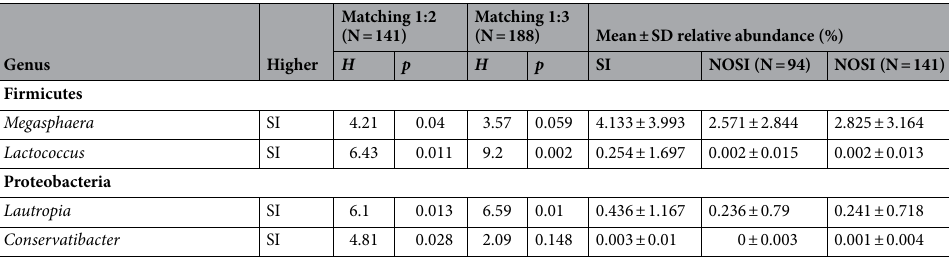
Table 5. Salivary bacterial genera and closest cultured relative species that are differentially abundant in suicidal ideation (SI) after controlling for sex, diet, and the presence of sleep issues. Relative abundances of significant differentially abundant closest species-relatives in individuals without SI (NOSI) and individuals with SI (SI) after propensity score matching on sex, diet factors, as before, and additionally on sleep issues. Two models, with 1:2 and 1:3 matching of SI to NOSI, were conducted and the Kruskal Wallis test results on the relative percent abundances presented. All species and genera presented here have a p value of < 0.05 in at least one of the two models. Highlighted are the species and genera that were consistent with the previous propensity score matching paradigm, which did not control for sleep, demonstrating the bacterial association is present with no regard to sleep as a potential confound.